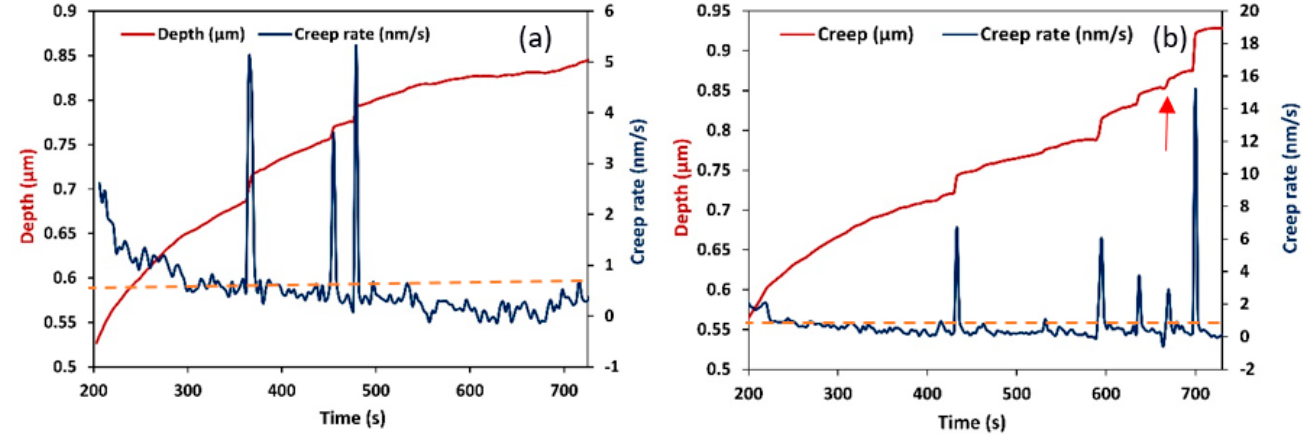
Figure 3. Two representative creep curves of HDPE, ( a , b ), showing penetration depth (red line) and creep rate (blue line) as a function of time during the creep segment through 500 s.